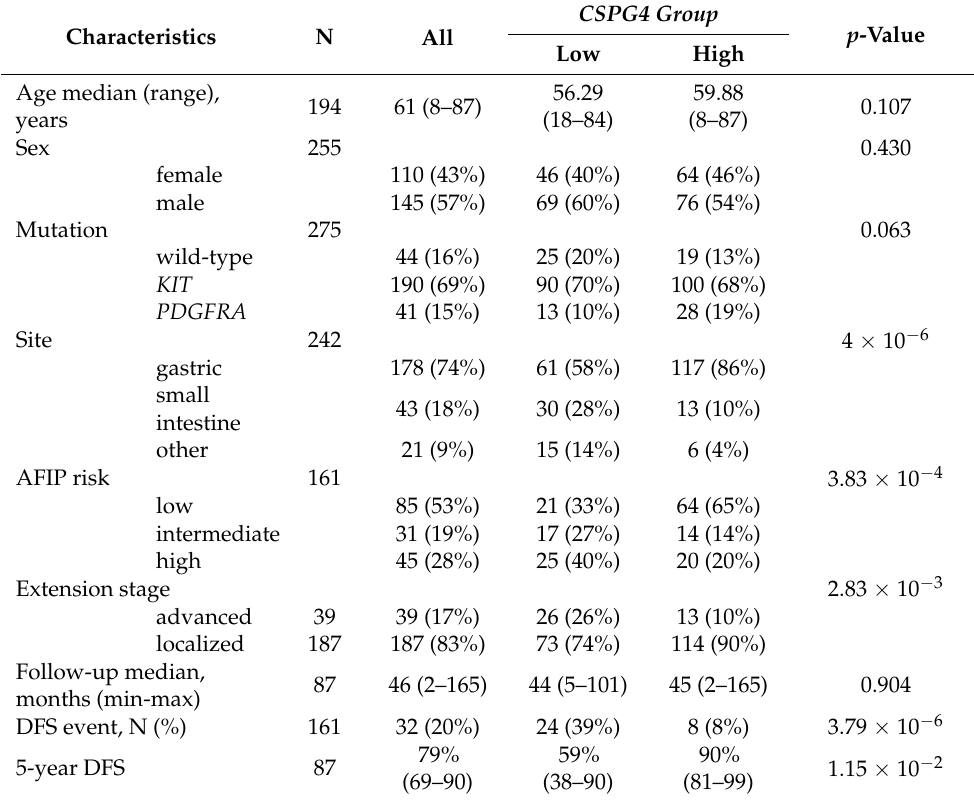
Table 1. Clinicopathological characteristics of patients and